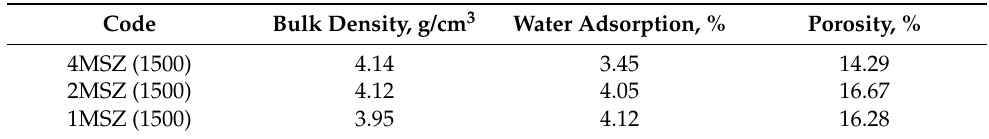
Table 3. Some physical properties of MSZ samples at 1500 ◦